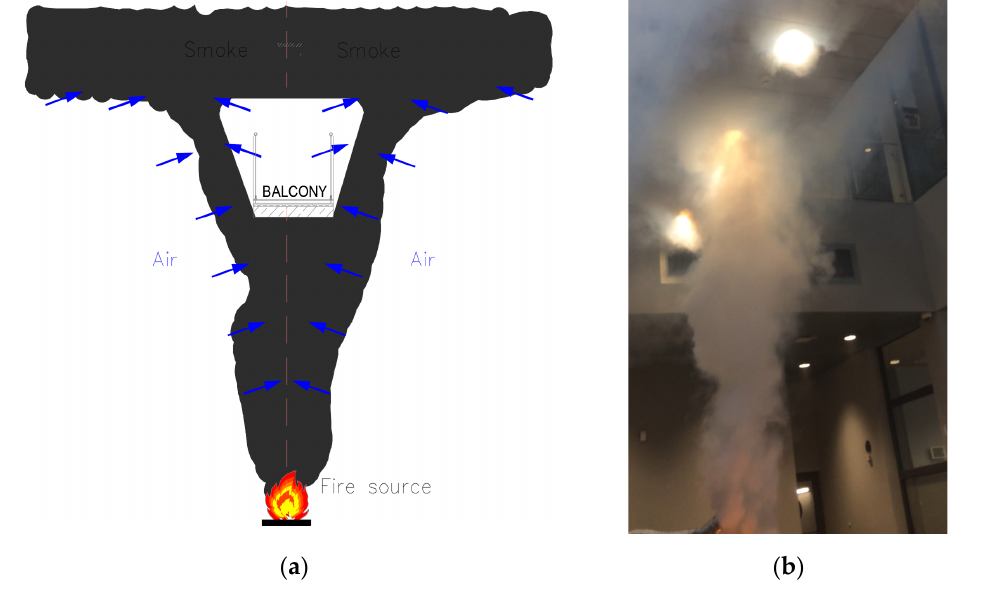
Figure 3. Complex atrium examples: ( a ) beams in the atrium space (photograph courtesy of Brzezi ń ska); ( b ) balconies in the atrium space (photograph courtesy of Brzezi ń ska).